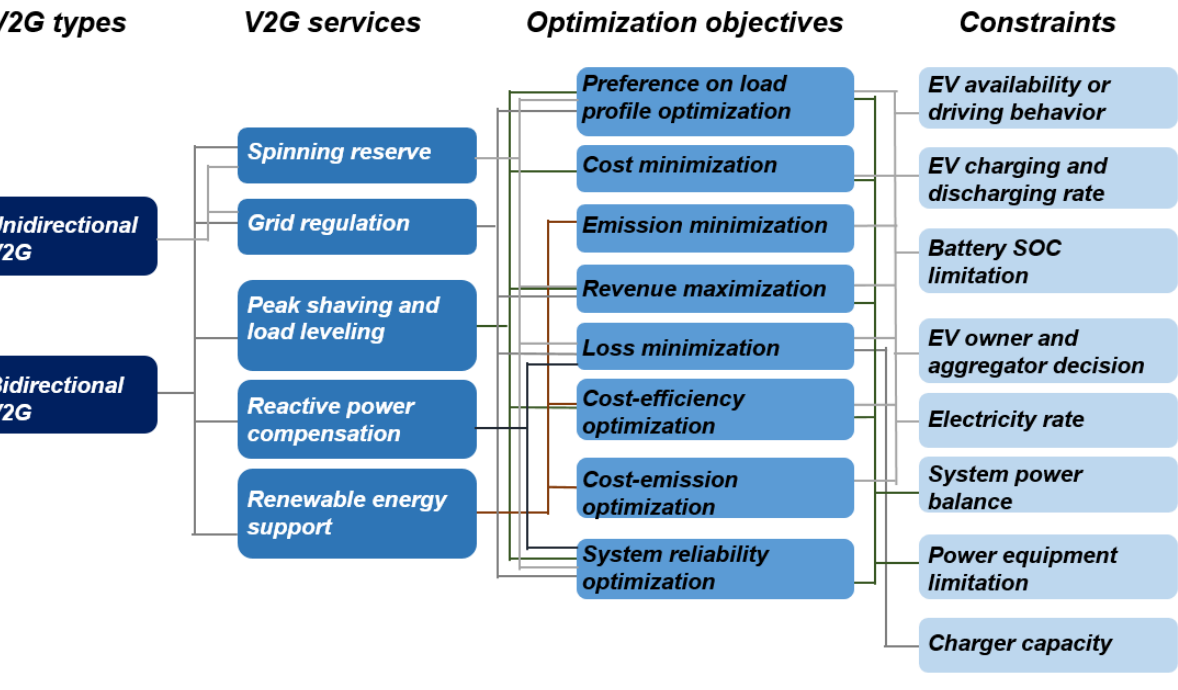
Figure 9. Relation diagram for V2G types, V2G services, optimization objectives, and constraints (redrawn from [9]).